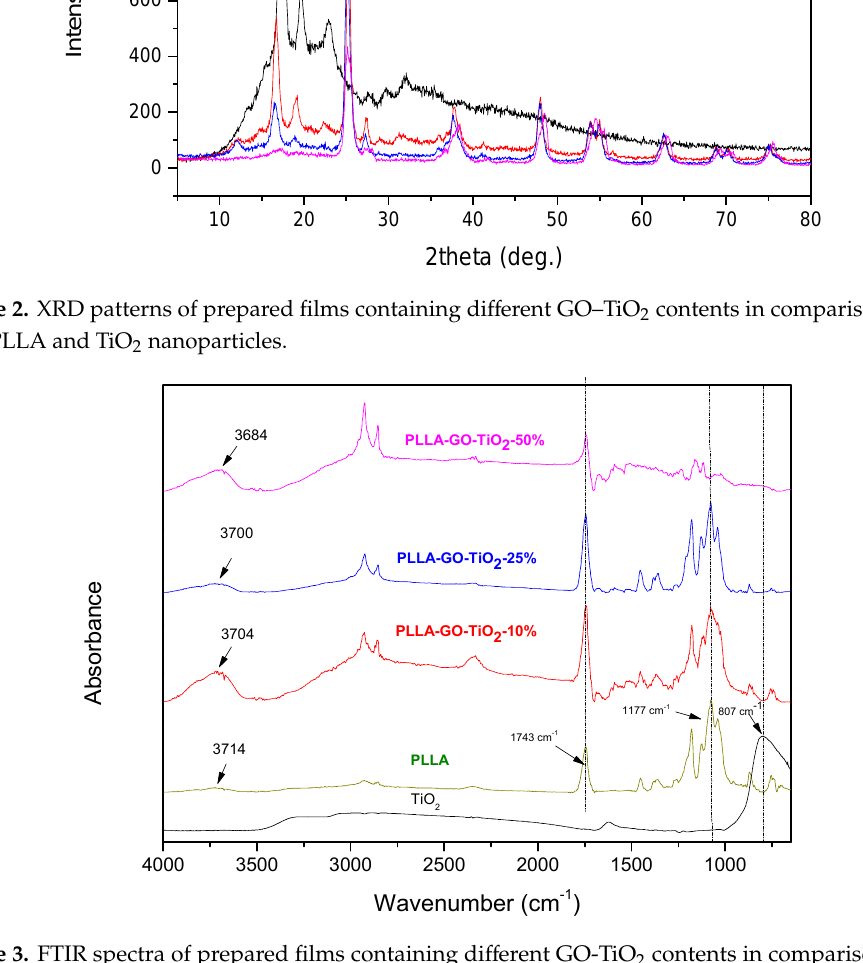
Figure 3. FTIR spectra of prepared films containing different GO-TiO 2 contents in comparison with neat PLLA and TiO 2 nanoparticles. .